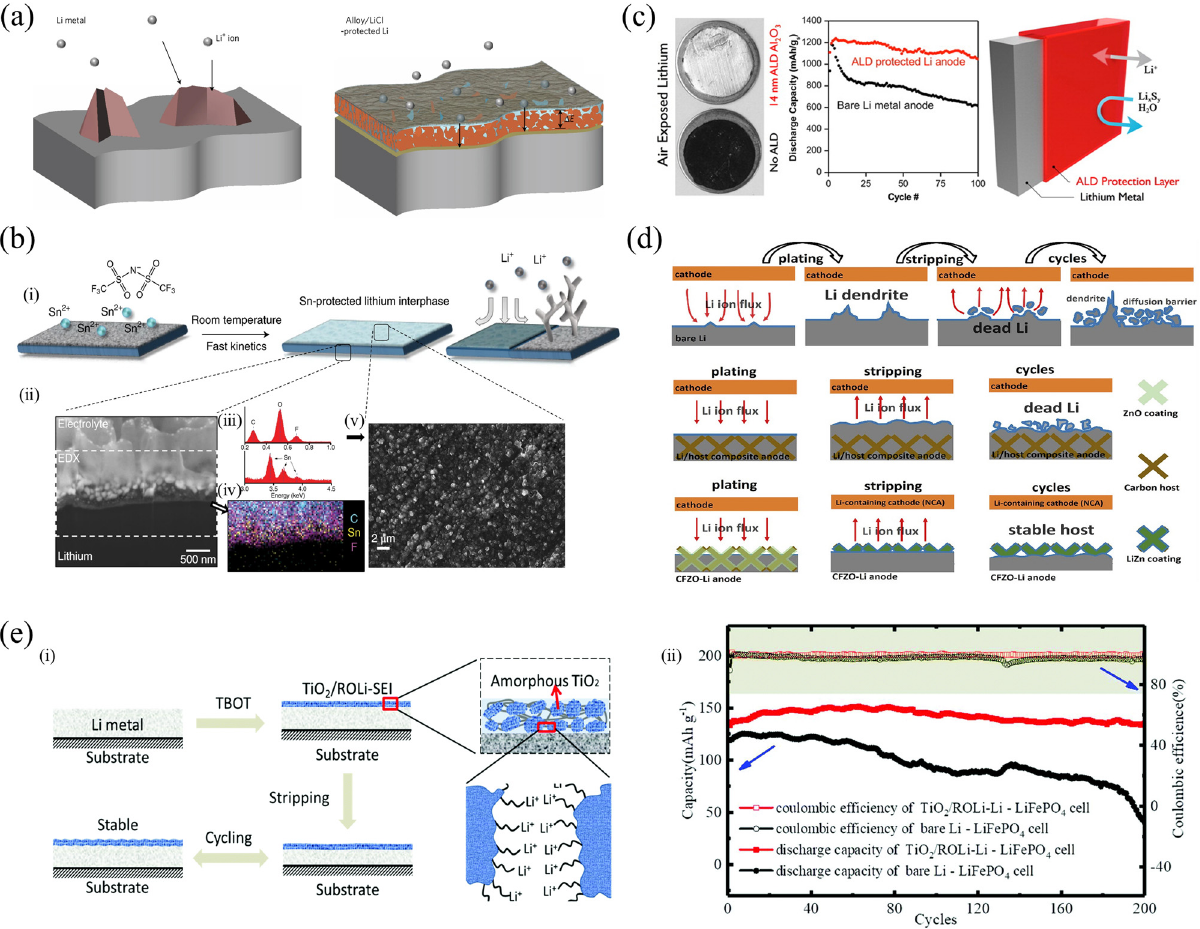
Figure 7: ( a ) Schematic depicting the function of the alloy - protected lithium foil, reprinted with permission from ref. [ 88 ] ; ( b ) hybrid anodes based on facile and fast Sn deposition on reactive metals produced by ion exchange: ( i ) a schematic illustration of the tin protection on the lithium metal electrode; ( ii ) a cross - section cryo - FIB - SEM image of the tin - protected lithium, with dashed lines showing the EDX location; ( iii ) typical EDX spectra of tin - protected lithium; ( iv ) EDX elemental mapping of fl uorine ( magenta ) and tin ( yellow ) in the dashed rectangular region; ( v ) room - temperature fi eld - emission SEM image of the surface morphology of the tin - protected lithium, reprinted with permission from ref. [ 89 ] ; ( c ) schematic diagrams of ALD Al 2 O 3 – Li metal and discharge capacity of bare Li metal anode and anode protected with 14